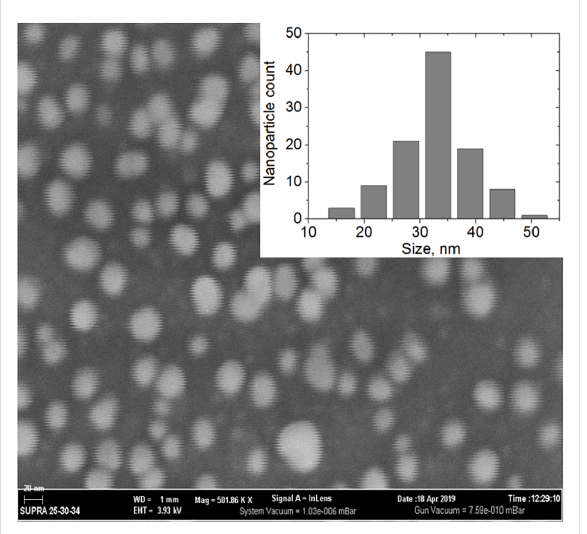
Figure 1: SEM image of Ag NPs and the corresponding size distribu- tion histogram. For SEM imaging Ag NPs were deposited onto a PEI- modified silicon conductive support by adsorptive